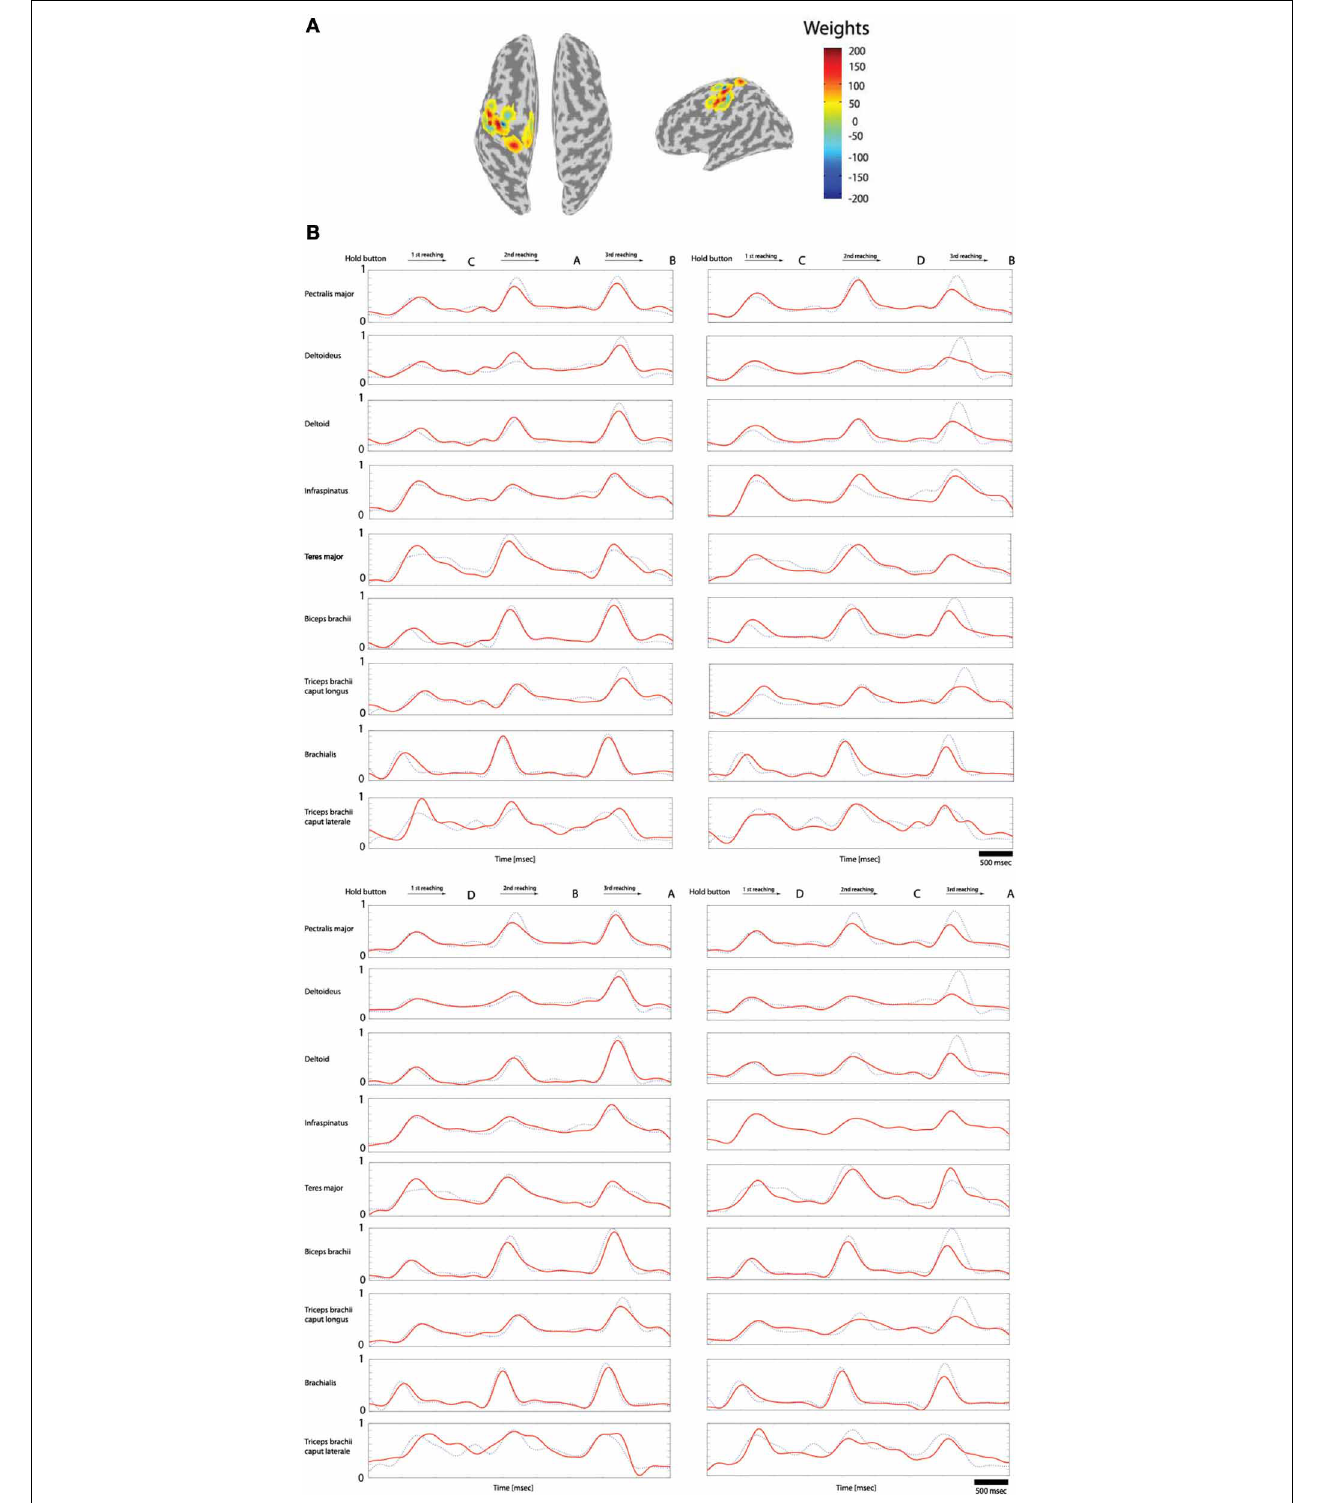
FIGURE 7 | Reconstruction of the filtered EMG signals from the cortical activities estimated on 33 vertexes in the left primary motor cortex. (A) The weights of the important features selected by the sparse linear regression to estimated filtered EMG signals from the cortical activities while